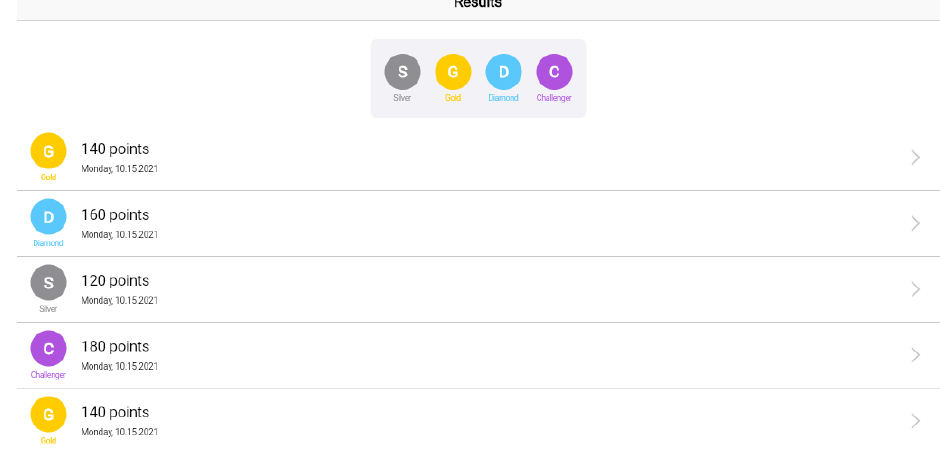
Figure 5. Web app dashboard.